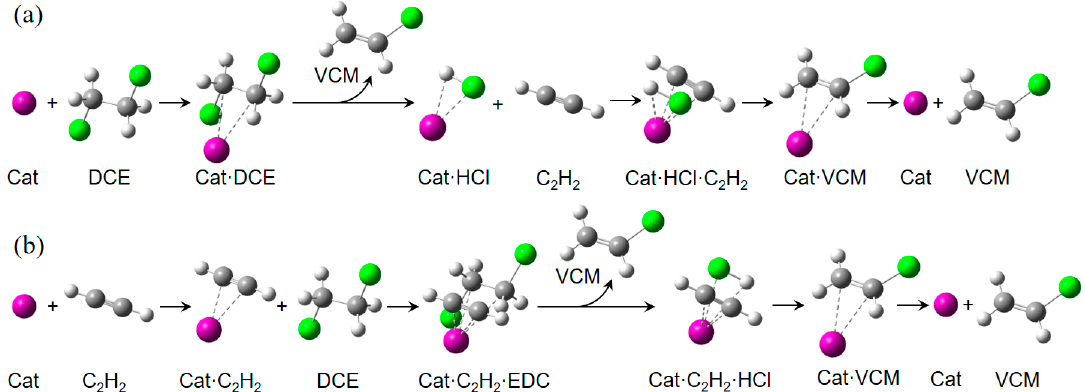
Figure 1. Illustration of two possible reaction pathways for 1,2-dichloroethane (DCE)-acetylene exchange reaction. ( a ) DCE decomposition pathway; ( b ) acetylene-DCE complex pathway. Table 1. Adsorption energies of DCE, C 2 H 2 , HCl, and vinyl chloride monomer (VCM) on the catalytic surfaces. Unit: kJ mol − 1 .